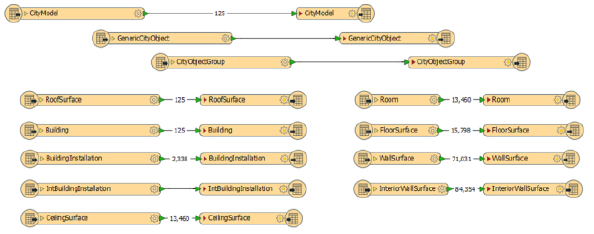
Figure 6. Work schema in FME